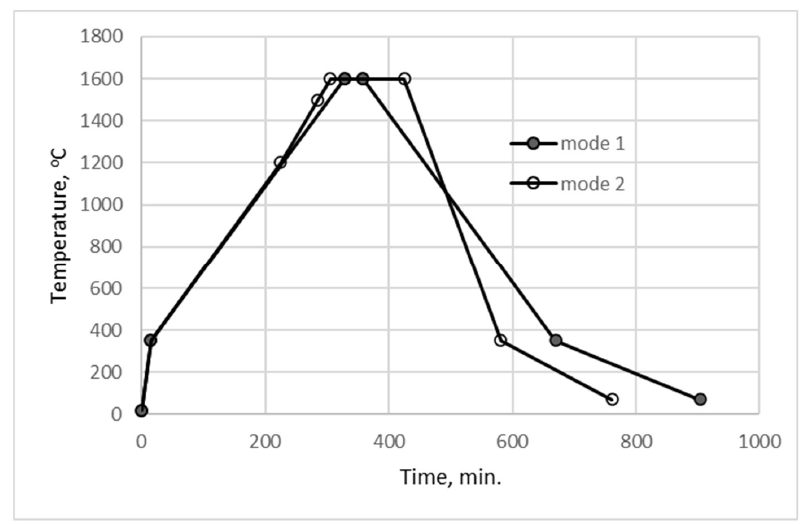
Figure 2. Sintering modes of uranium dioxide pellets on the pilot plant.